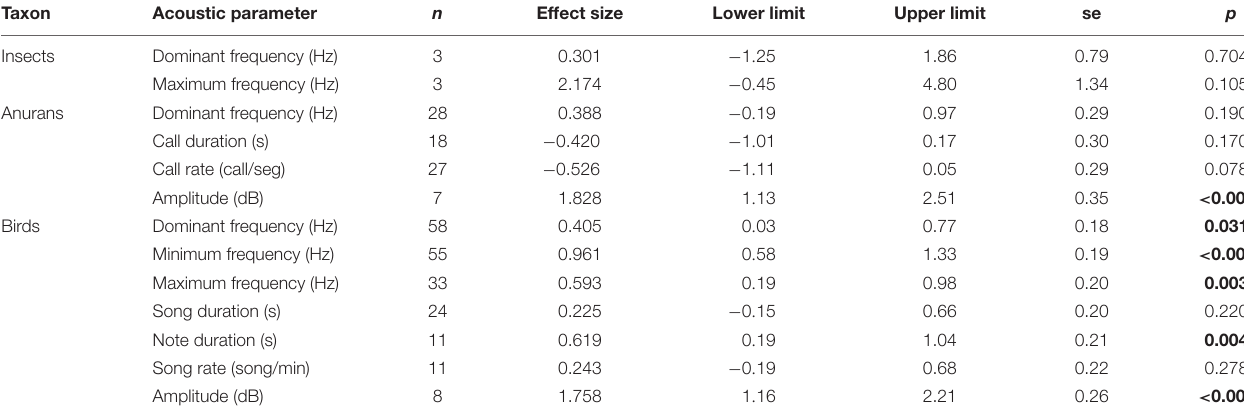
TABLE 1 | Results of the multilevel meta-analysis.